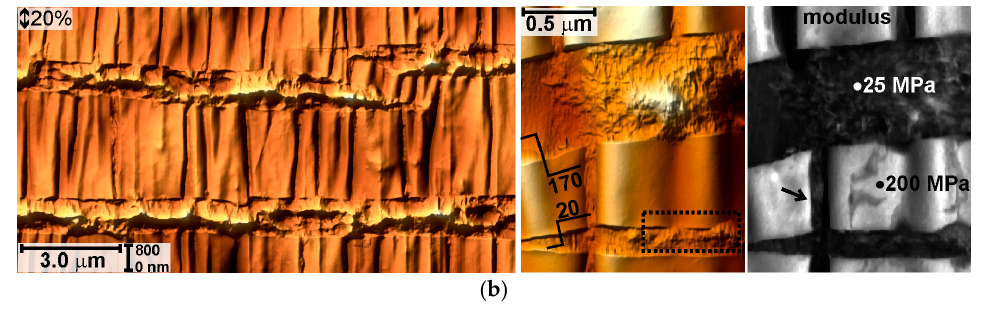
Figure 4. AFM images of PU after the PIII 1-16 and fatigue loading to 20%: open cracks in the unloaded ( a ) and stretched ( b ) states. Cracks with overlapping edges are also observed on the unloaded surface (shown by arrow in ( a )). The height differences in the cracks are indicated (in nm); arrow and rectangle in ( b ) indicate polymer squeezed from the cracks.